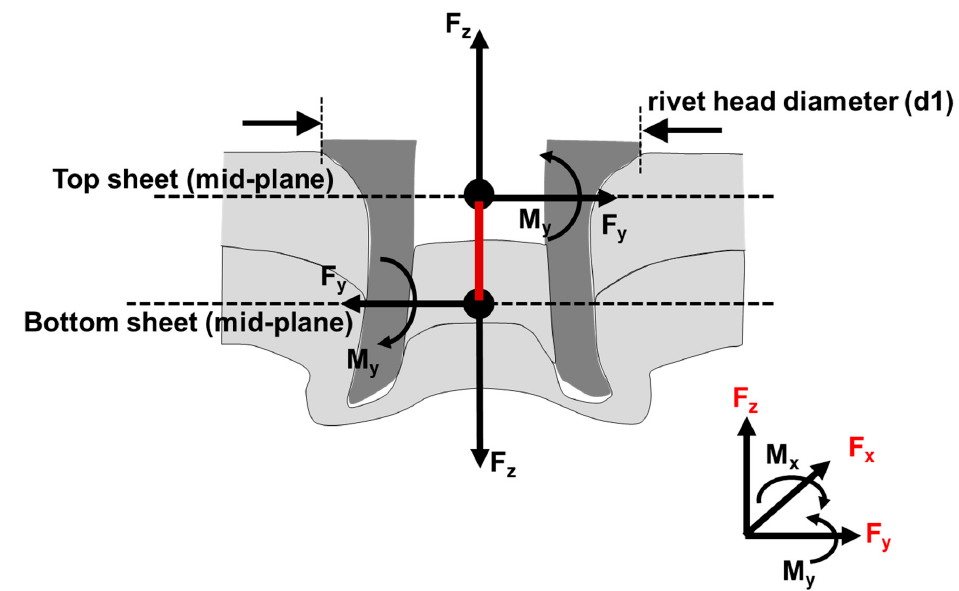
Figure 4. Representative of the SPR joint used in this study superimposed with various forces and moments. The forces and moments shown in insert on right corner are used in the Battelle structural stress method to calculate the components of the structural stress at the edge of the rivet.